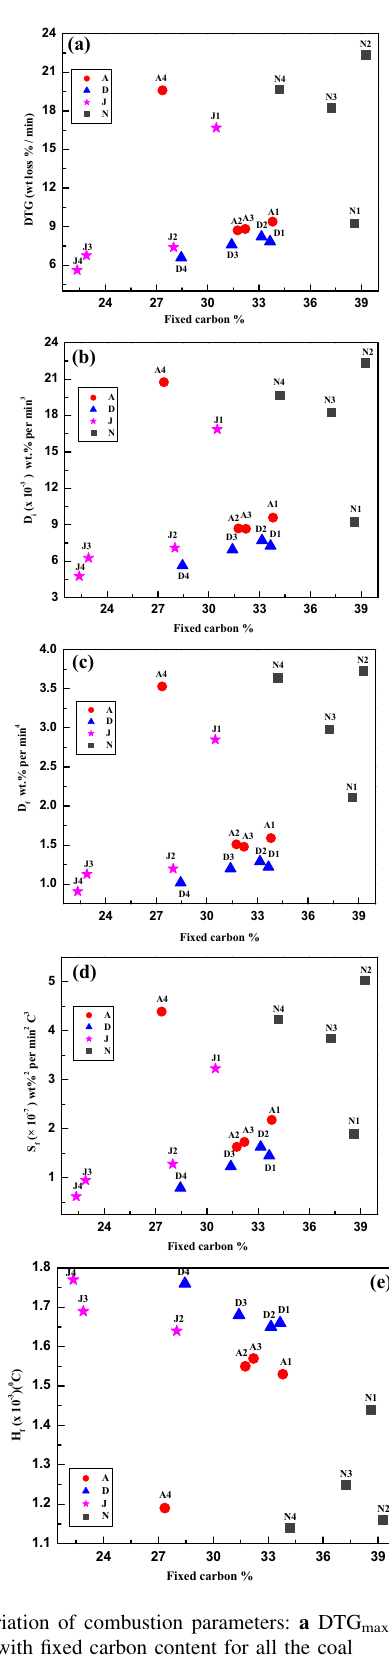
Fig. 4 Variation of combustion parameters: a DTG max , b D i , c D f , d S f , e H f with fixed carbon content for all the